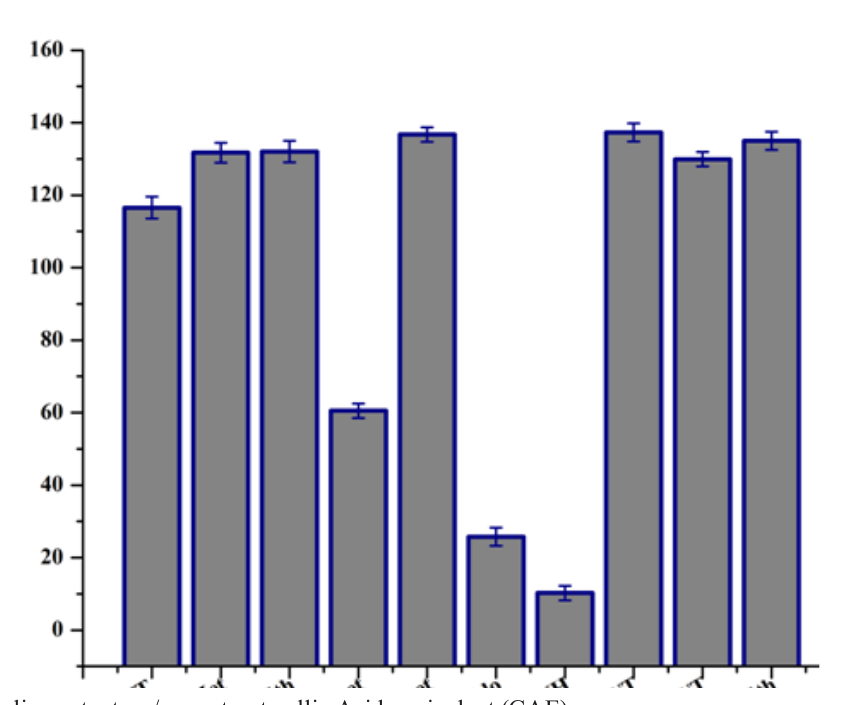
FIGURE 3 - Total phenolic content μ g/mg extract gallic Acid equivalent (GAE). Values obta ined are as mean ± Standard error from three separate experiments. WT: water, Met: methanol, Eth: ethanol, Eacet: ethyl acetate, Acet: acetone, Chlo: chloroform, NH: n-Hexane, Met + WT; methanol + water, Eth + WT; ethanol + water, Met + Eth; methanol +